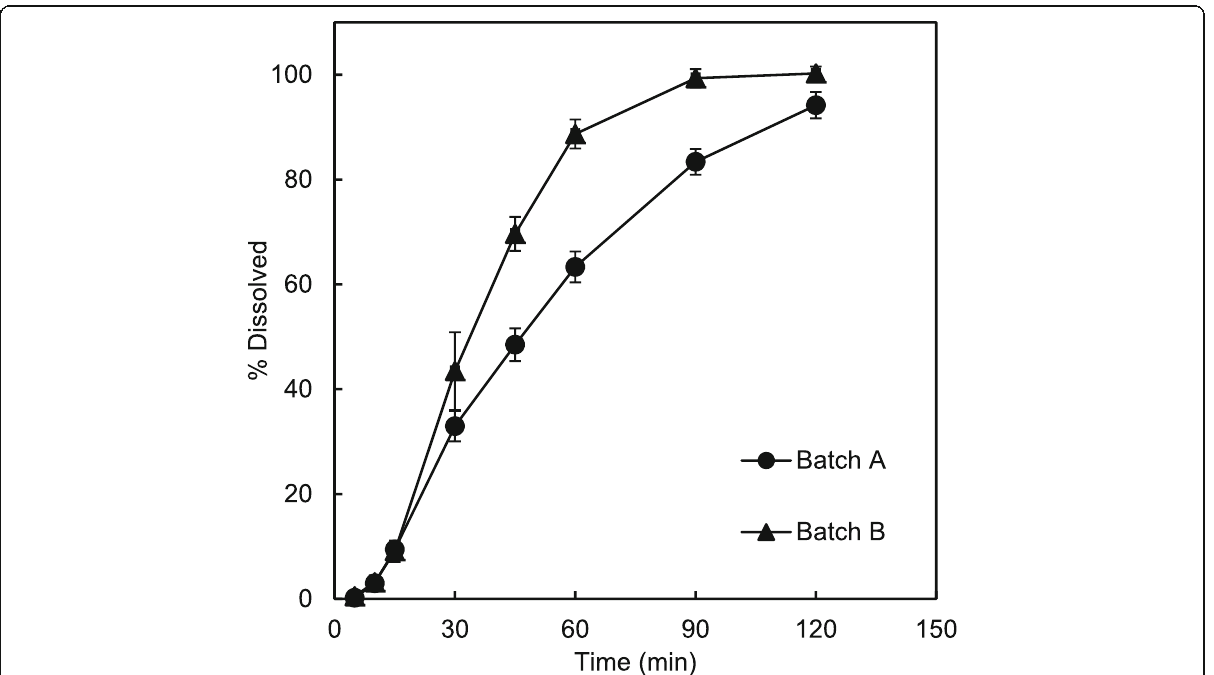
Fig. 1 Dissolution profiles of different batches of innovator itraconazole capsules in pH1.2 medium. Dissolution testing was conducted in an USP apparatus II using a volume of 900 mL of medium at an agitation rate of 50